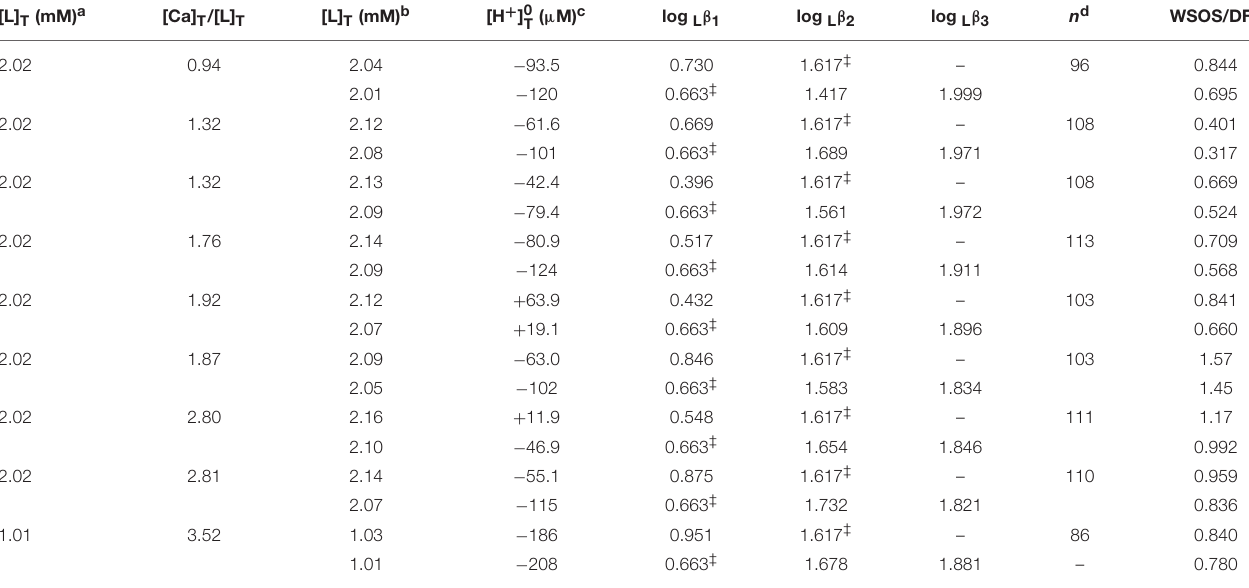
log L β 1 obtained from the third step in the fourth and final step. The regressions from step 3 and 4 are shown in Table 7 .